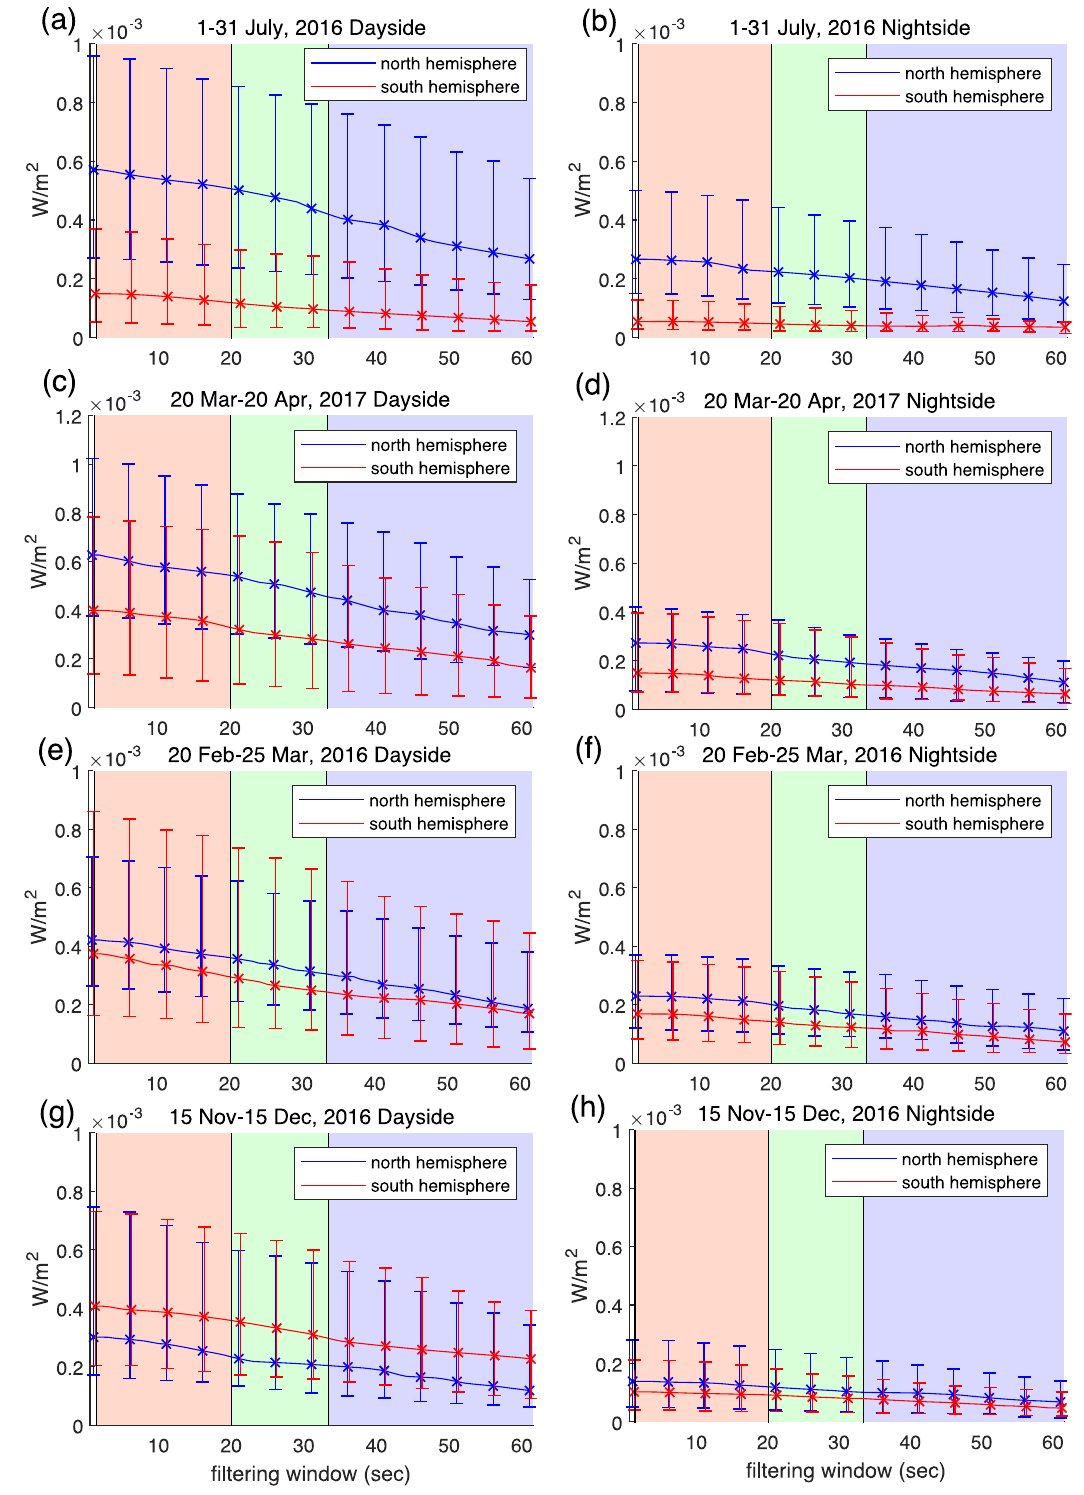
Fig. 1 Mean Poynting fl uxes observed by Swarm A satellite crossings of the northern and southern auroral zones. Dayside ( a , c , e , g ) and nightside ( b , d , f , h ) auroral zone crossings for northern near-summer solstice (1 – 31 July, 2016; a and b ), northern spring period (20 March – 20 April, 2017; c and d ), northern equinox period (20 February – 25 March, 2016; e and f ) and northern near-winter solstice (15 November – 15 December, 2016; g and h ), during periods where the orbits are con fi ned to the noon – midnight local time sector (see also Supplementary Fig. 9). The panels compare Poynting fl ux as a function of transverse spatial scale, derived using a time-domain Savitzky-Golay fi lter, in the northern and southern hemispheres (blue and red, respectively) and plot the median Poynting fl ux power values (solid line) and the 25% and 75% quartiles (error bars). Three regions separating small-scale (10 – 150 km), mesoscale (150 – 250 km) and large-scale (>250 km) phenomena as observed along the Swarm orbit, as per the de fi nitions in ref. 37 are denoted by pink, green and blue backgrounds,